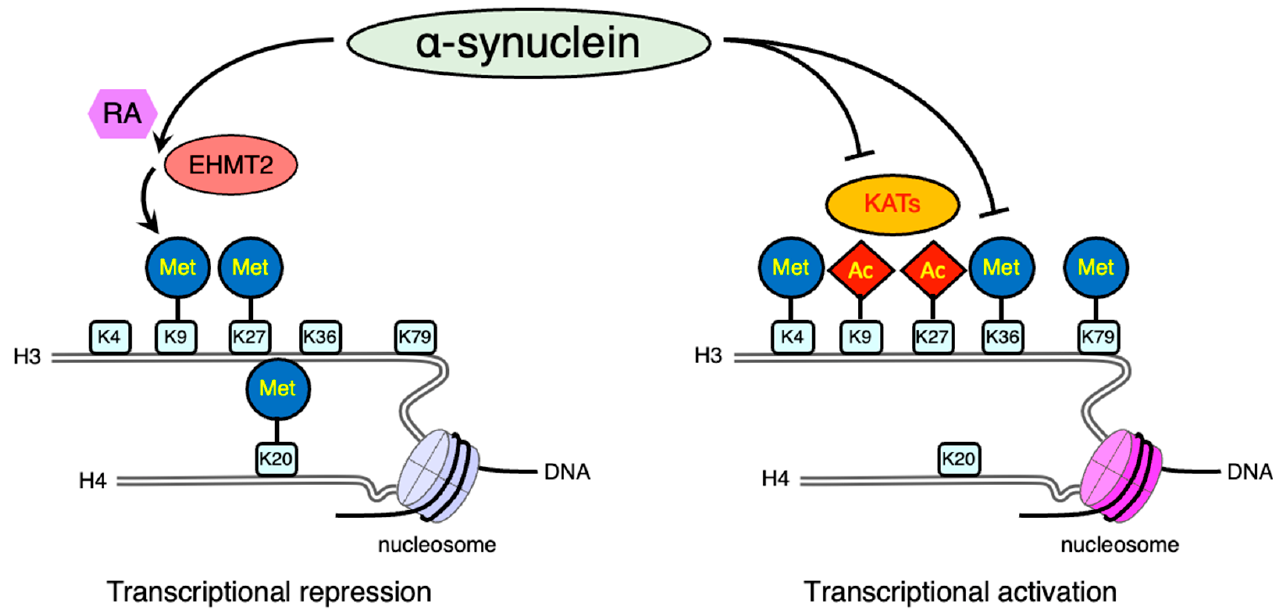
Figure 2. Schematic illustration of post-translational modifications of histone proteins affected by alpha-synuclein ( α S). Lysine methylation has different functions depending on its residues. Methylation (Met) of H3 lysine 9 (K9), lysine 27 (K27), and H4 lysine 20 (K20) is often associated with transcriptional repression. In contrast, the methylation of H3 lysine 4 (K4), lysine 36 (K36), or lysine